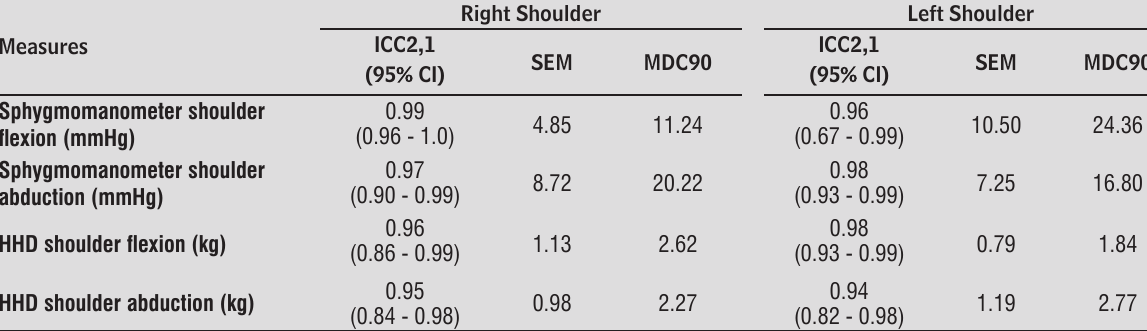
Table 1 - Intra-rater reliability